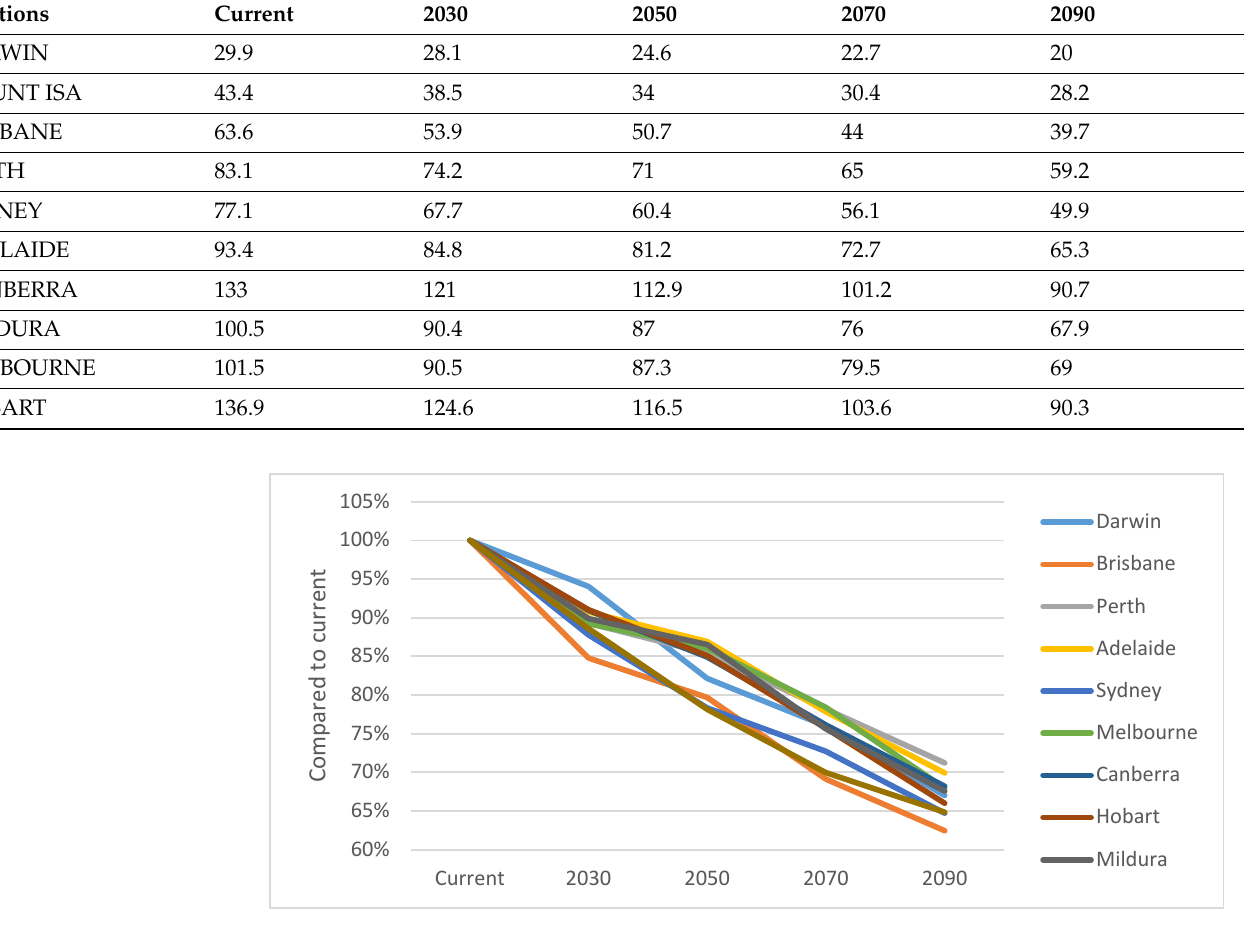
Figure 9. Benchmarking of small hospital’s yearly boiler heating needs.